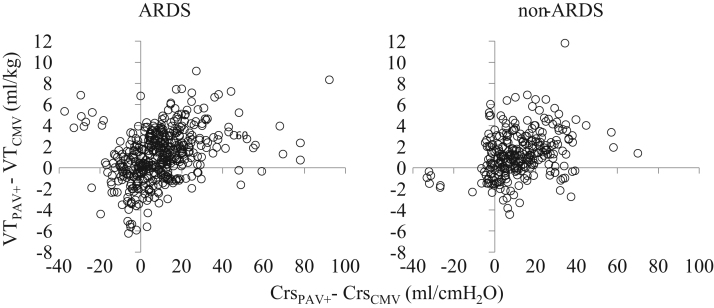
Individual relationships in ARDS and non-ARDS patients between the change in VT (difference in VT between PAV+ and CMV, VTPAV+−VTCMV) and that of Crs (difference in Crs between PAV+ and CMV, CrsPPAV+−CrsCMV) when the patients were switched from CMV to PAV+. ARDS: 64 patients, 457 measurements, left. Non-ARDS: 44 patients, 287 measurements, right. Each patient was characterized by a number of data points equal to the number of measurements during PAV+ (see also Fig. 3). The percentage of measurements in which VT increased (compared to CMV) while CrsPAV+ decreased (compared to CMV) did not differ between ARDS and non-ARDS patients (10.3% vs. 7.3%, p=0.19).